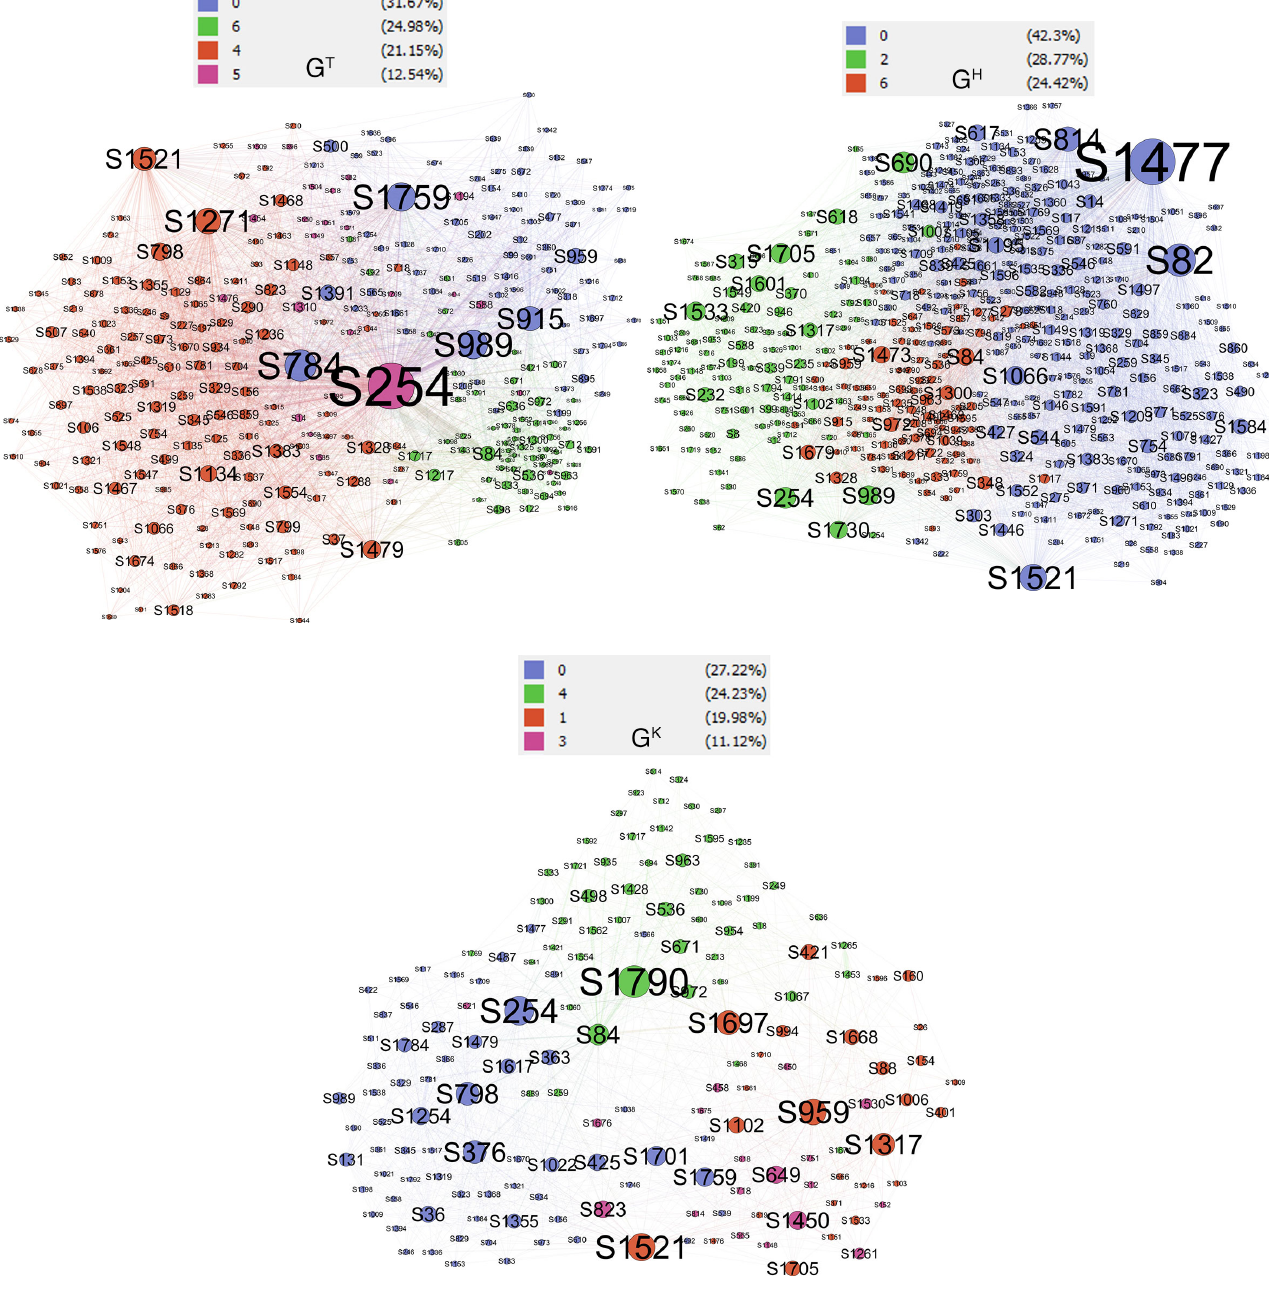
Figure 6. Prominent communities of each layer of the